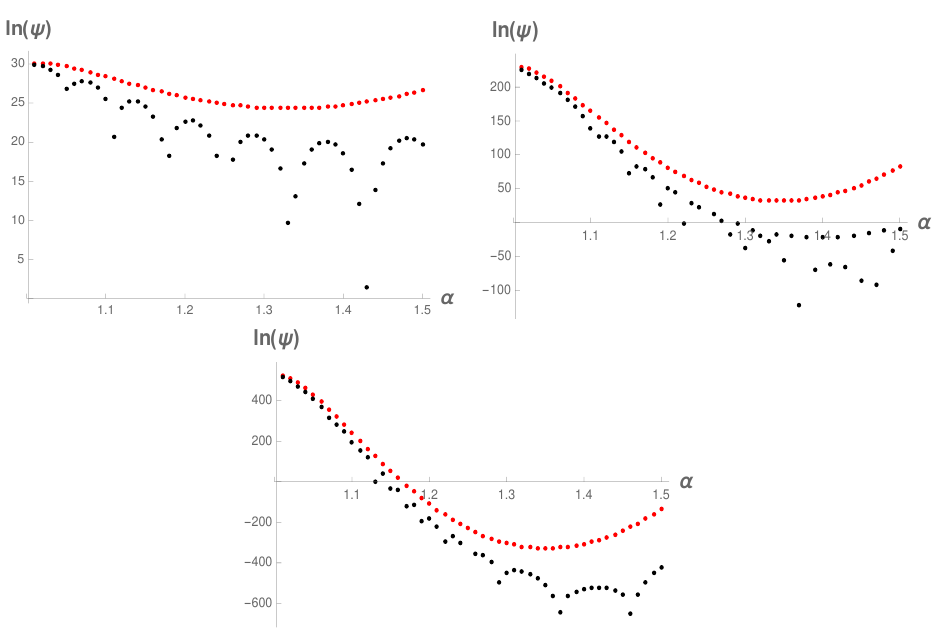
Figure 3 . Comparison of eq. (6.18) (red) versus the exact matrix elements calculated using the Van- dermonde formula (6.3) (black) at N = 20 (top left), N = 100 (top right) and N = 200